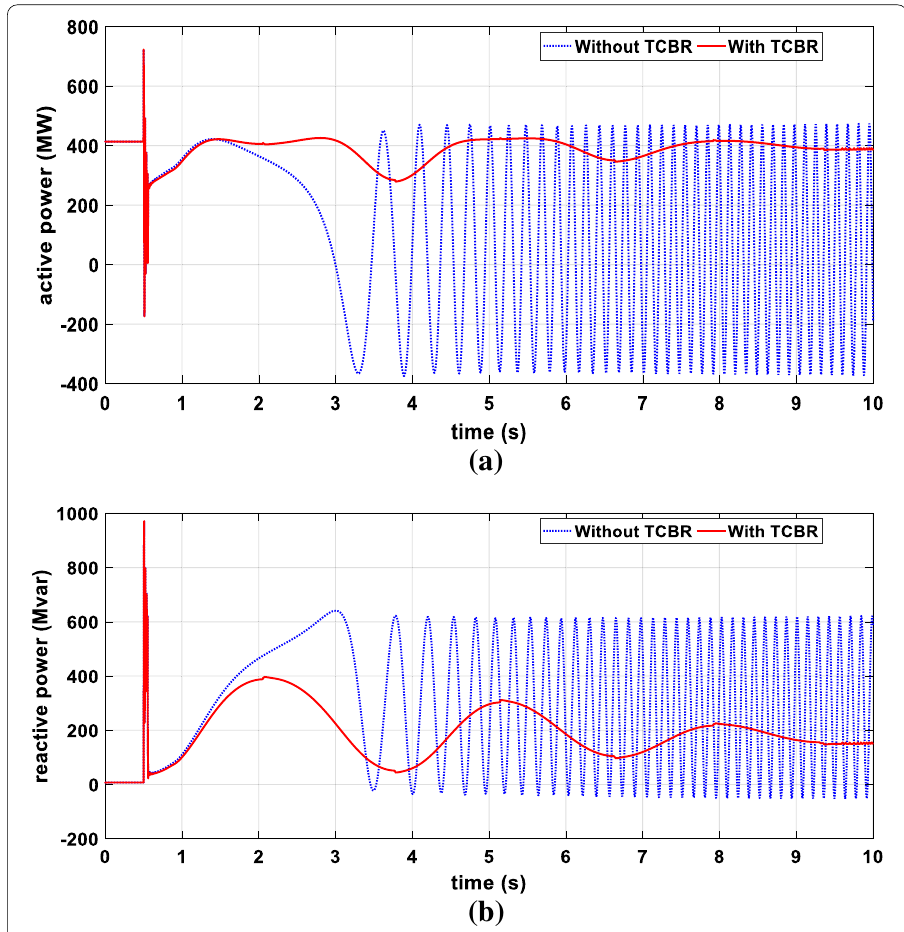
Fig. 13 Power flow responses due to three‑phase fault with and without dynamic brake, a inter‑area active power flow, b inter‑area reactive power